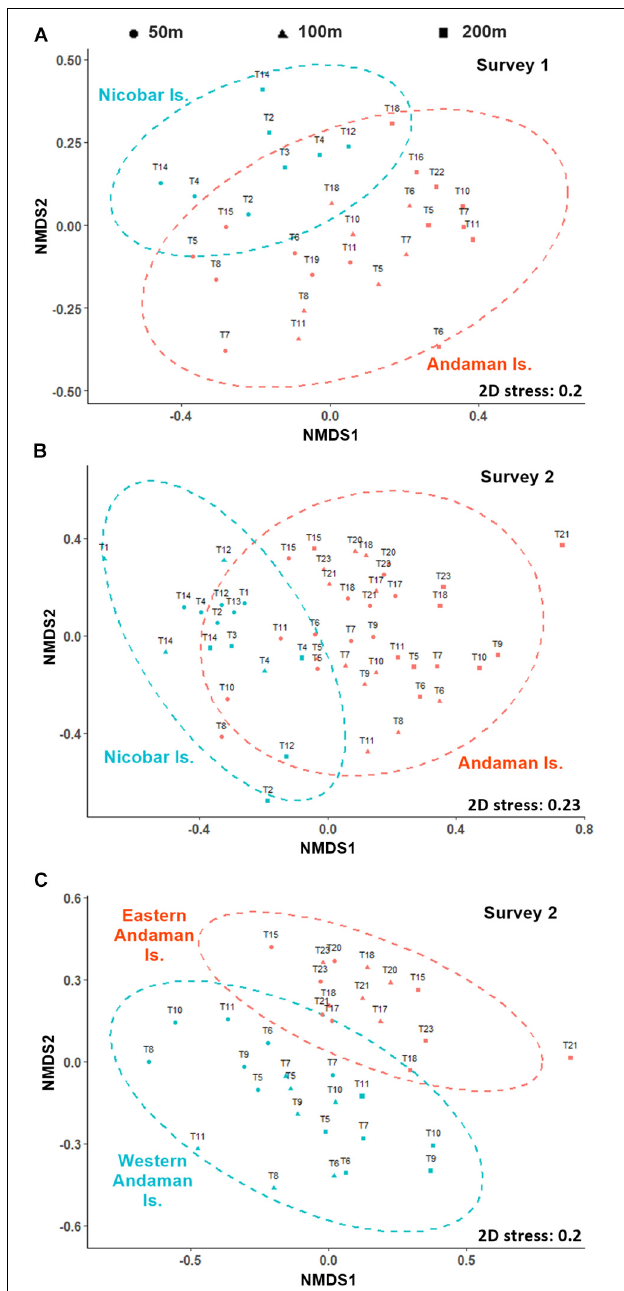
FIGURE 9 | Non-metric multi-dimensional scaling (nMDS) plots of polychaete species data (based on the Bary-Curtis similarity matrix of the square root transformed data) showing regional distictions among, (A) Andaman (orange) and Nicobar (blue) Island groups in survey 1 (500 µ m), (B) among Andaman (orange) and Nicobar Island (blue) groups in survey 2 (300 µ m, and (C) among eastern (orange) and western (blue) margins of Andaman Islands in S2 (300 µ m) ( • 50 m sites, (cid:78) 100 m sites, and (cid:4) 200 m sites).